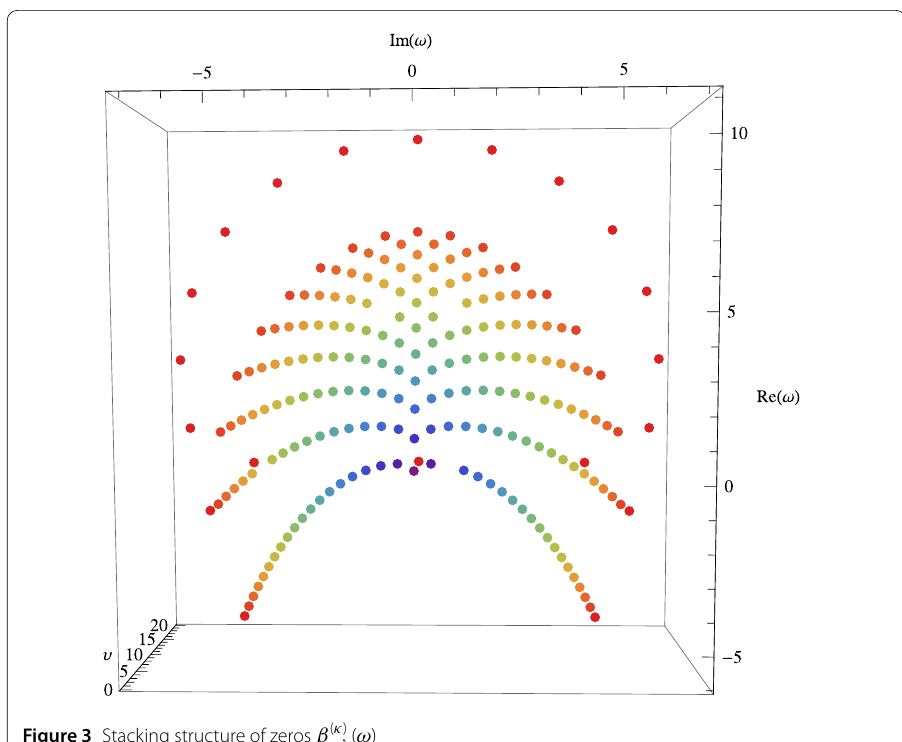
Figure 3 Stacking structure of zeros β ( κ ) υ